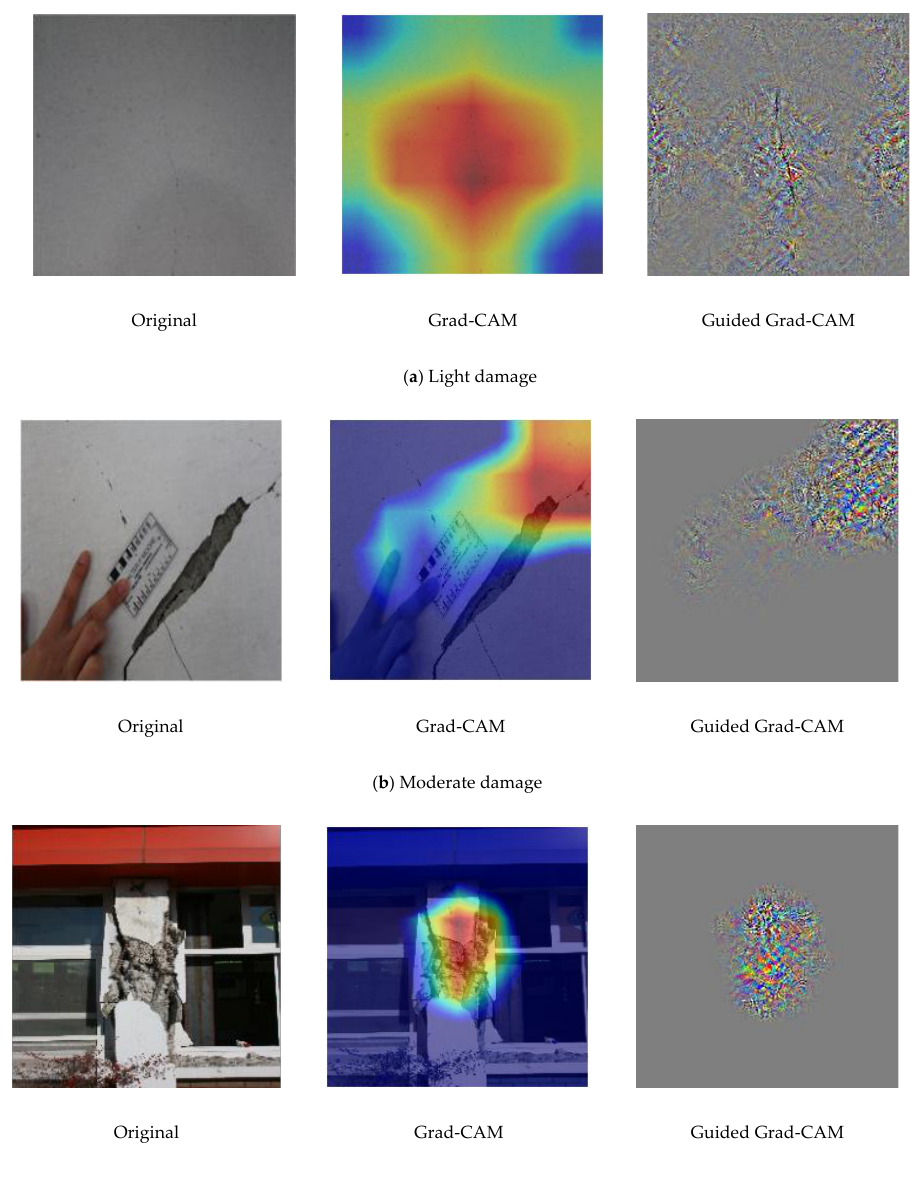
Figure 12. Representative images illustrating damage visualization and localization analyses via gradient-weighted class activation mapping (Grad-CAM) methods for images of ( a) light, ( b ) moder- ate, and ( c ) severe